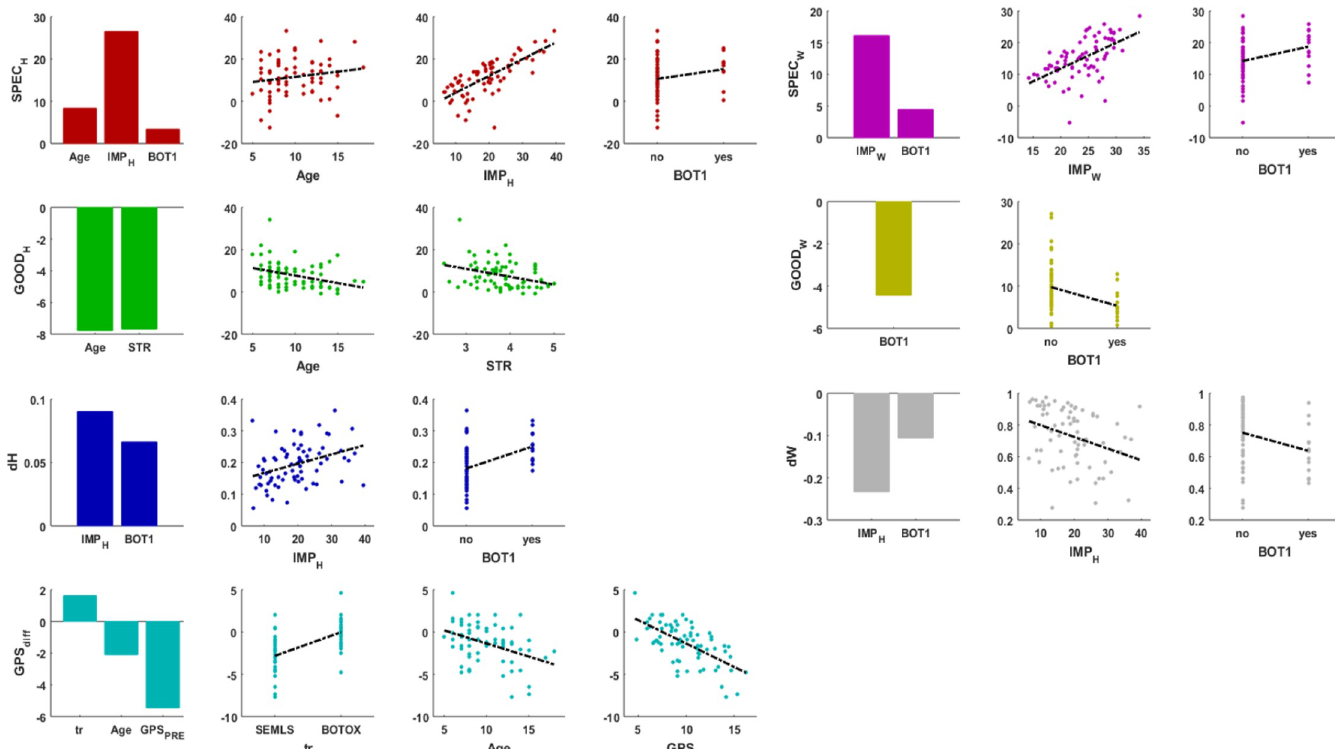
Fig 7. Results from the stepwise regression analysis. Results are reported for each of the dependent variables. The bar graphs report the effect sizes of the statistically significant independent variables of the fitted models. In the scatter plots the dependent variables are plotted as a function of each of the independent variables included in the model. SPEC specificity (%); GOOD goodness (%); IMP impairment of the subject pre-treatment (%); Age at time of surgery (years); STR average pre-treatment strength report; dW change in synergy weights expressed as the correlation coefficient between pre- and post-treatment; dH change in synergy activation profiles expressed as RMSE between pre- and post-treatment; GPS PRE gait profile score pre-treatment (degrees); GPS diff difference between GPS PRE and GPS POST (degrees); BOT1 rectus femoris injection (yes/no); tr treatment (BOTOX/SEMLS). Subscripts W and H indicate that the signal reconstruction was performed optimizing the weights or the activation profiles,